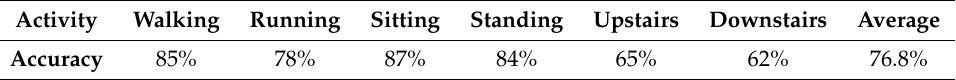
Table 6. Activity recognition accuracy over the external